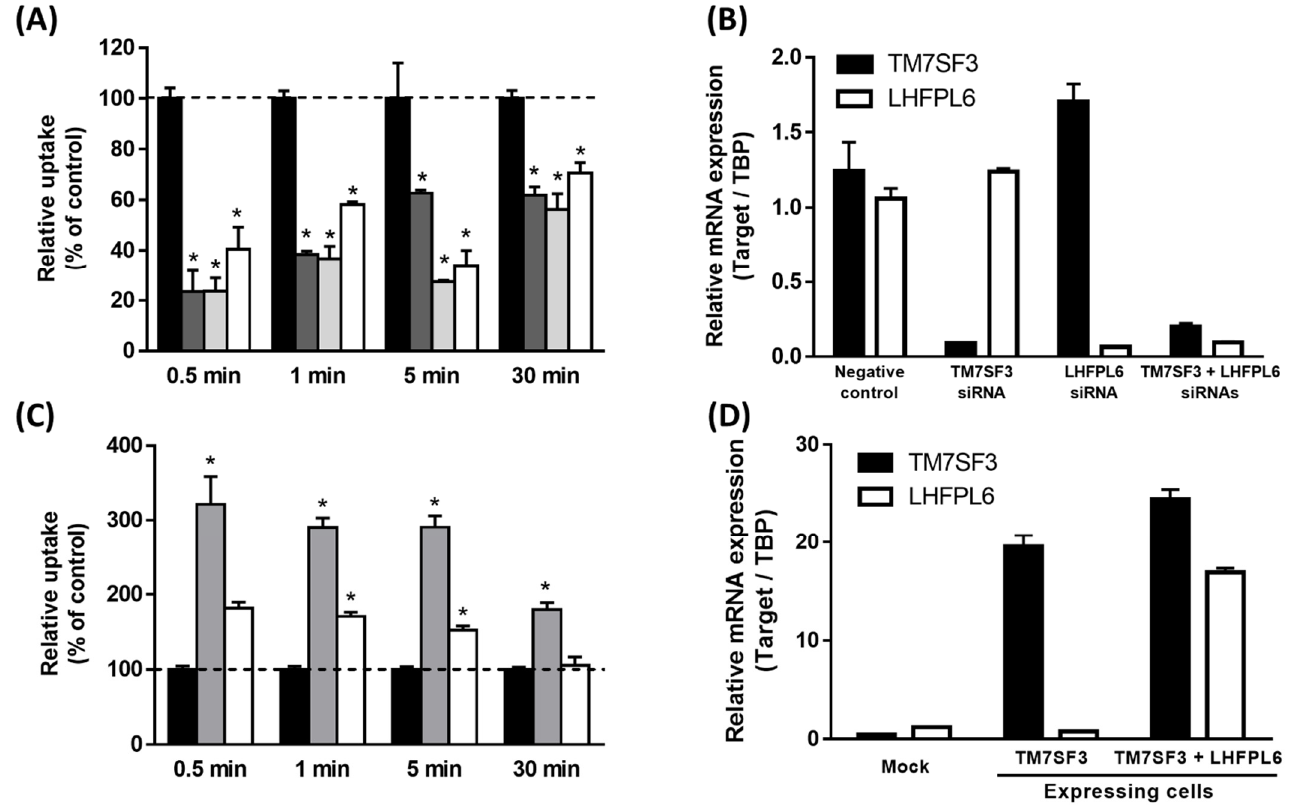
Figure 7. Effects of TM7SF3 and LHFPL6 on the cellular uptake of pyrilamine analogue. ( A ) Intracellular uptake of pyrilamine analogue in TM7SF3 or/and LHFPL6 knockdown hCMEC/D3 cells was measured at 37 °C, for 0.5, 1, 5 and 30 min. The black, dark gray, light gray and white columns represent the negative control, TM7SF3 knockdown, LHFPL6 knockdown, and their double knockdown cells, respectively. ( B ) The mRNA expression of TM7SF3 and LHFPL6 in hCMEC/D3 cells treated with the respective siRNAs. ( C ) Uptake of pyrilamine analogue in HEK293 cells stably expressing TM7SF3 or both TM7SF3 and LHFPL6 was evaluated at 37 °C. The black, gray, and white columns show the results for mock, TM7SF3-expressing, and TM7SF3 + LHFPL6-expressing cells, respectively. ( D ) The mRNA expression in HEK293 cells stably overexpressing TM7SF3 and LHFPL6 was measured by qPCR and normalized to that of TBP. Cellular uptake in A and C is shown as percent of the control. Each column represents the mean ± standard error ( n = 4). * p < 0.05 indicates a significant difference versus the negative control.